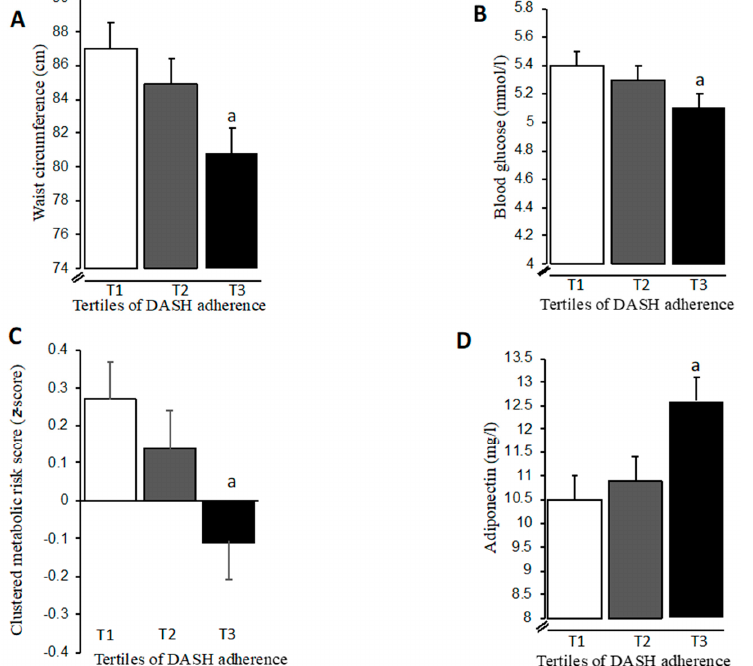
Figure 1. Adjusted means ( ± SEM) of waist circumference ( A ), blood glucose ( B ), clustered metabolic risk ( C ) and adiponectin level ( D ) across tertiles (T1, T2, T3) of DASH adherence in older women. a p < 0.05 compared to T1. Means are adjusted by total energy intake, medication and time in MVPA, and additionally by waist circumference (blood glucose and